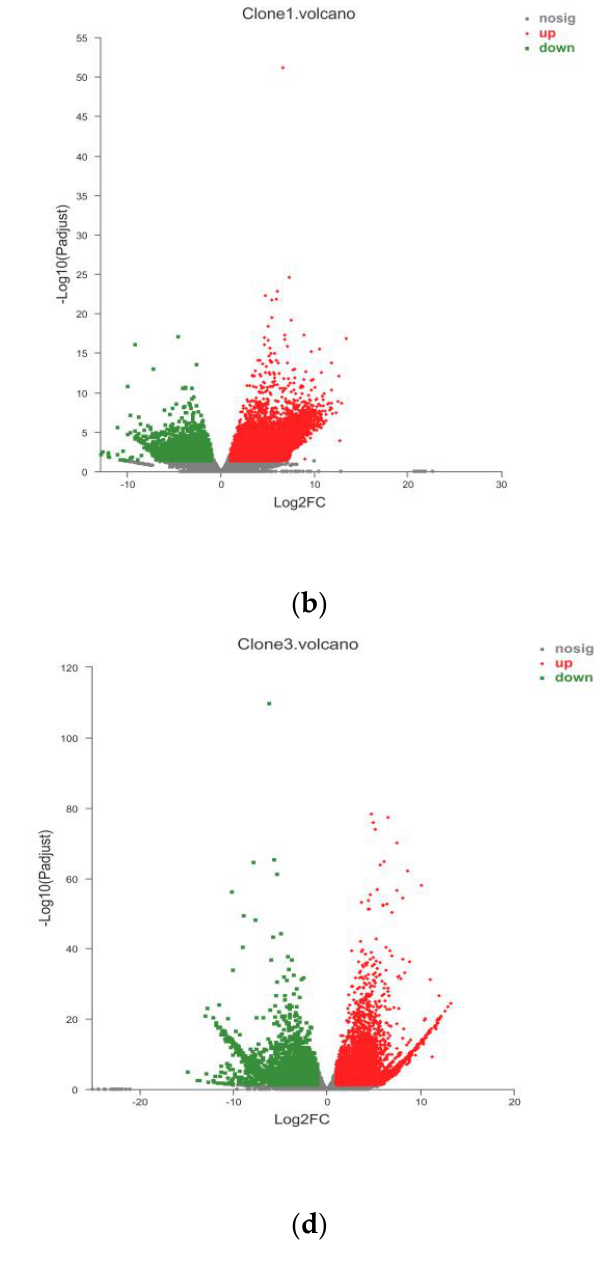
Figure 3. ( a ) Differences in expression levels of different clones (S1-vs-S4); ( b ) differences in expression levels of clone 1 (S1-vs-S4); ( c ) differences in expression levels of clone 2 (S1-vs-S4); ( d ) differences in expression levels of clone 3 (S1-vs-S4). In the volcano map, y -axis represents the fold change value of gene expression difference between two stages and x -axis shows the statistical test value of gene expression difference; that is, the higher the point is, the more significant the difference is; the farther away from the center, the greater the multiple of difference.